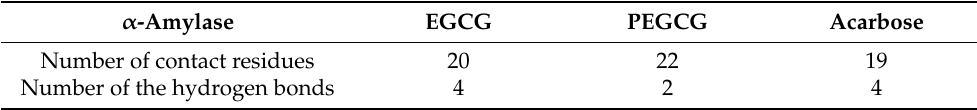
Table 6. Binding overview of the ligands with α -amylase.